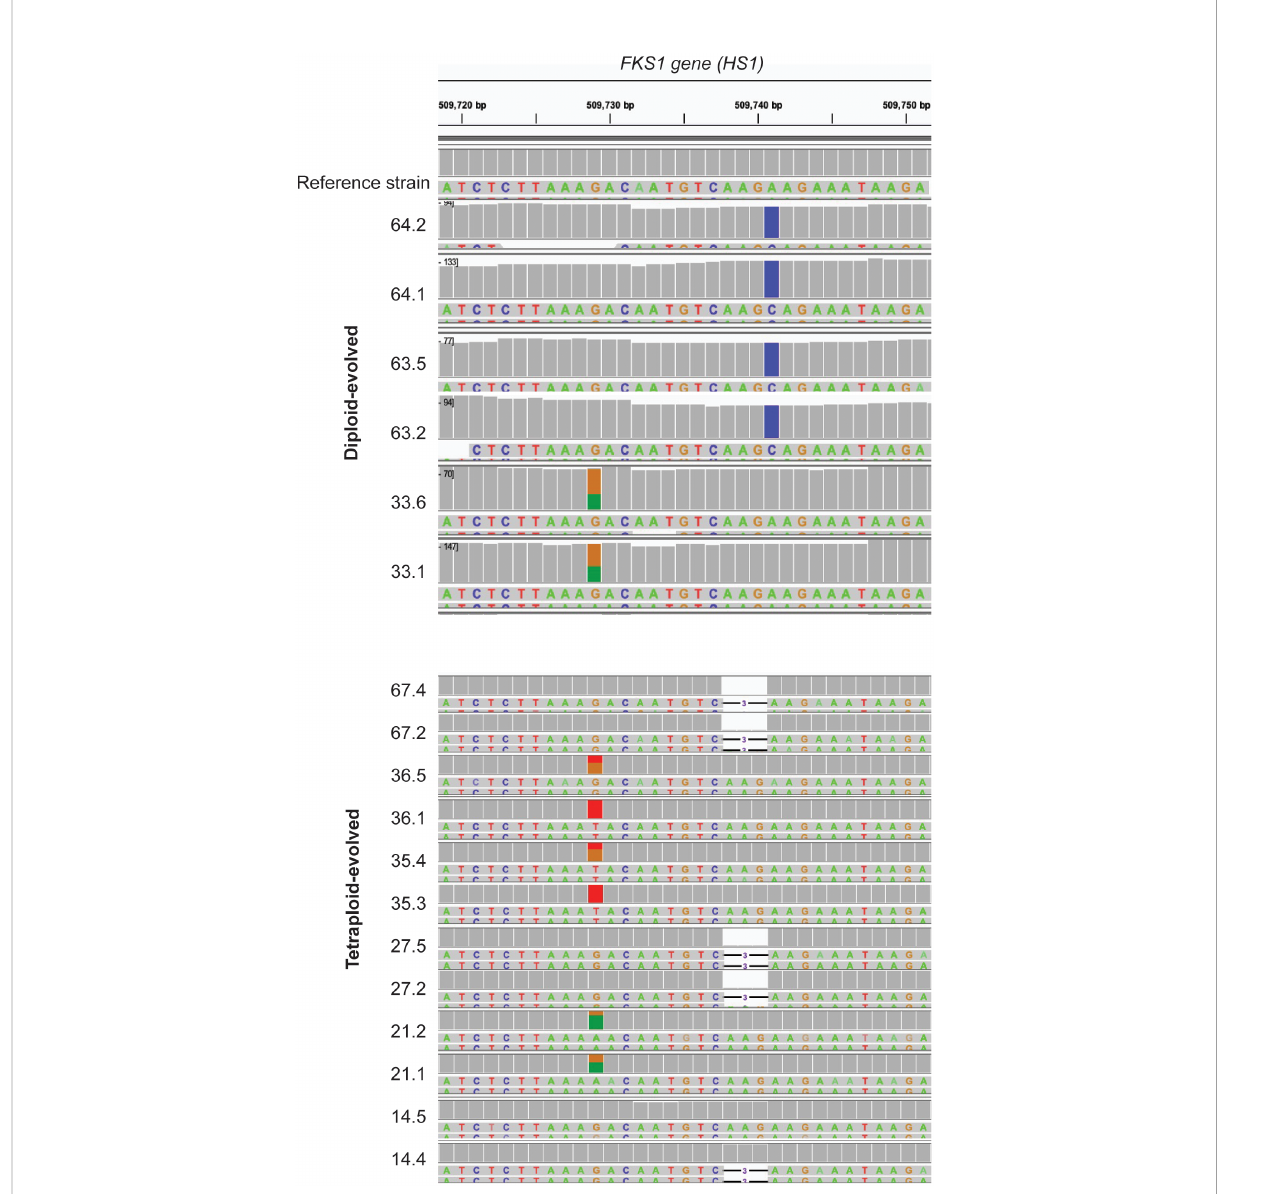
FIGURE 4 FKS1 mutations differ between diploid- and tetraploid-evolved isolates. SNPs in the HS1 region of FKS1 if C.albicans diploid (top) and tetraploid- evolved (bottom) isolates on day59 of evolution in caspofungin. Each colored nucleotide represents a SNP in the region. A fully colored box represents a homozygous SNP, while partially colored boxes represent heterozygous